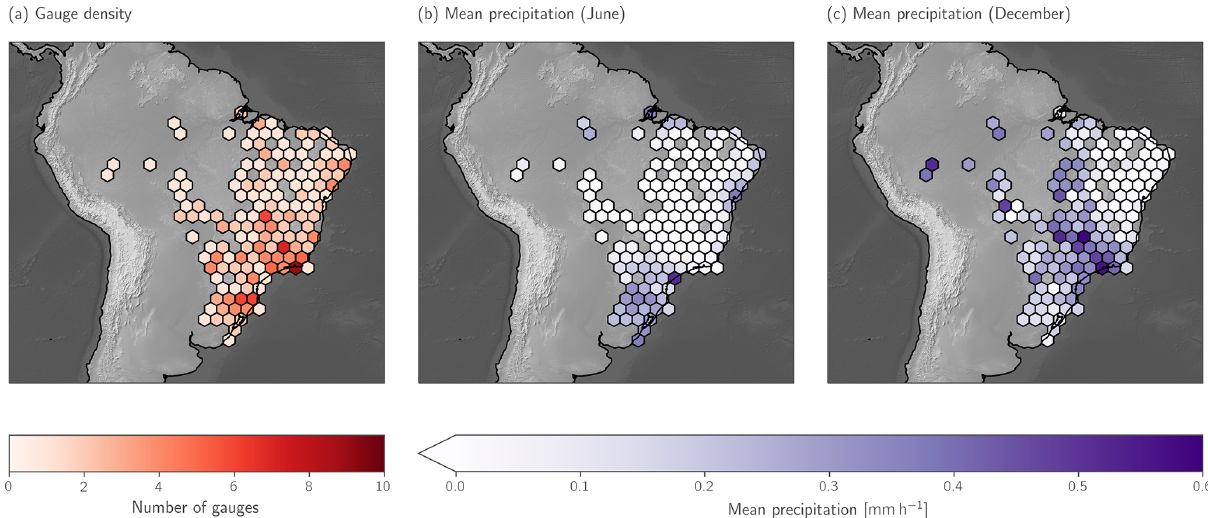
Figure 1. Overview of the rain gauge data from June and December 2020 used to validate the retrievals. Panel (a) displays their spatial distribution by means of the number of gauges falling into each hexagon. Hexagon-free areas are not covered by any gauges. Panels (b) and (c) show the mean precipitation measured by all gauges falling into each